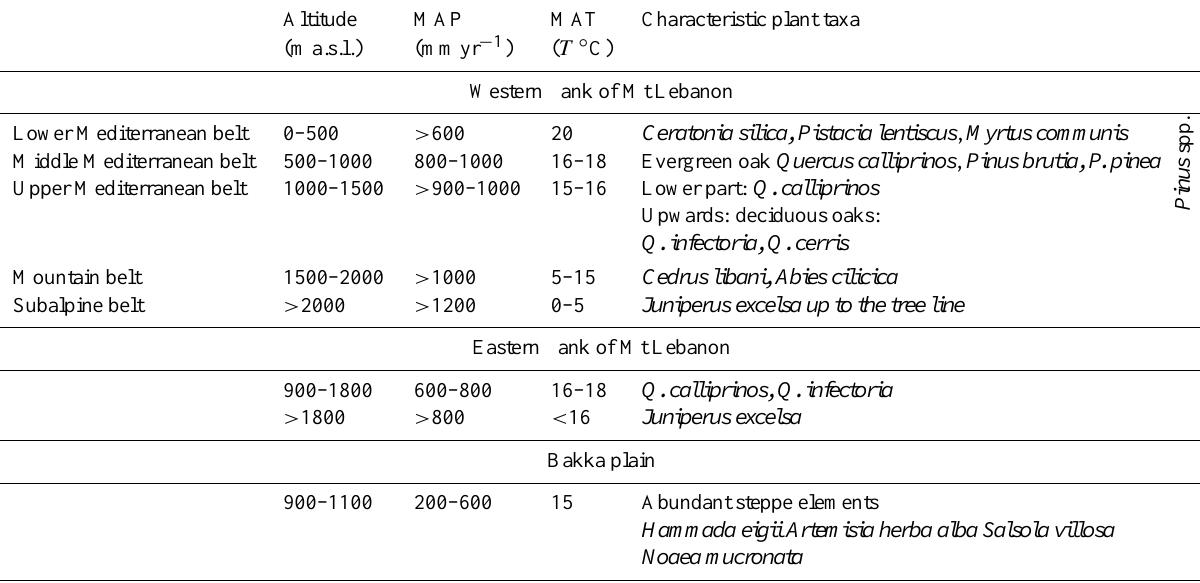
Table 1. Distribution of the modern vegetation belts in the Yammoˆuneh area as a function of location, altitude, mean annual precipitation (MAP) and mean annual temperature (MAT). After Abi-Saleh and Safi (1988). Altitude MAP MAT Characteristic plant taxa